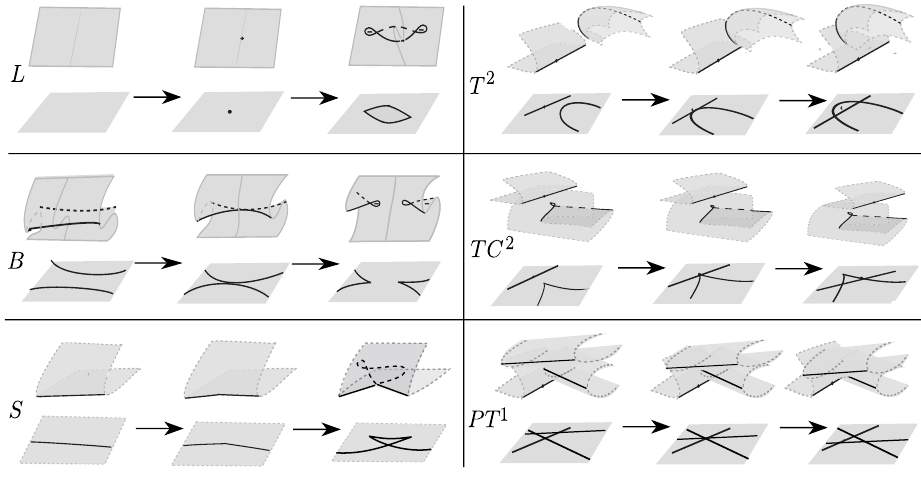
Figure 5. Examples of some codimension one transitions (see